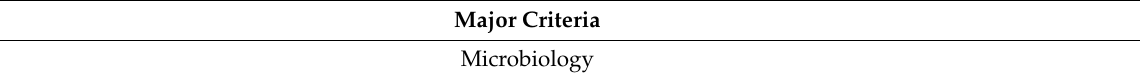
Table 2. The Novel 2019 International CIED Infection